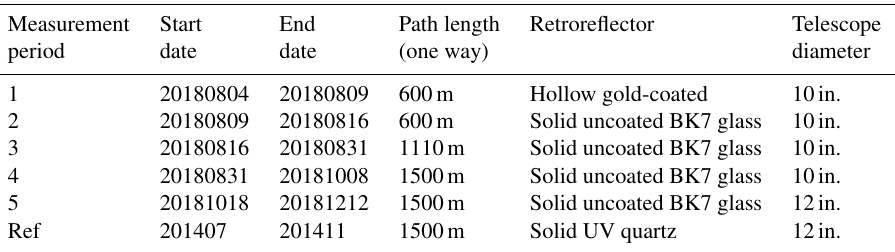
Figure 4. Map showing the location of EMAI relative to Sydney and Wollongong. The measurement path and corresponding elevation profile are shown in Fig. 8. Map data © Google Earth. Table 2. Summary of the open-path NIR instrument setup at EMAI. Previous work by Griffith et al. (2018) in Heidelberg is used as a reference. Dates are in